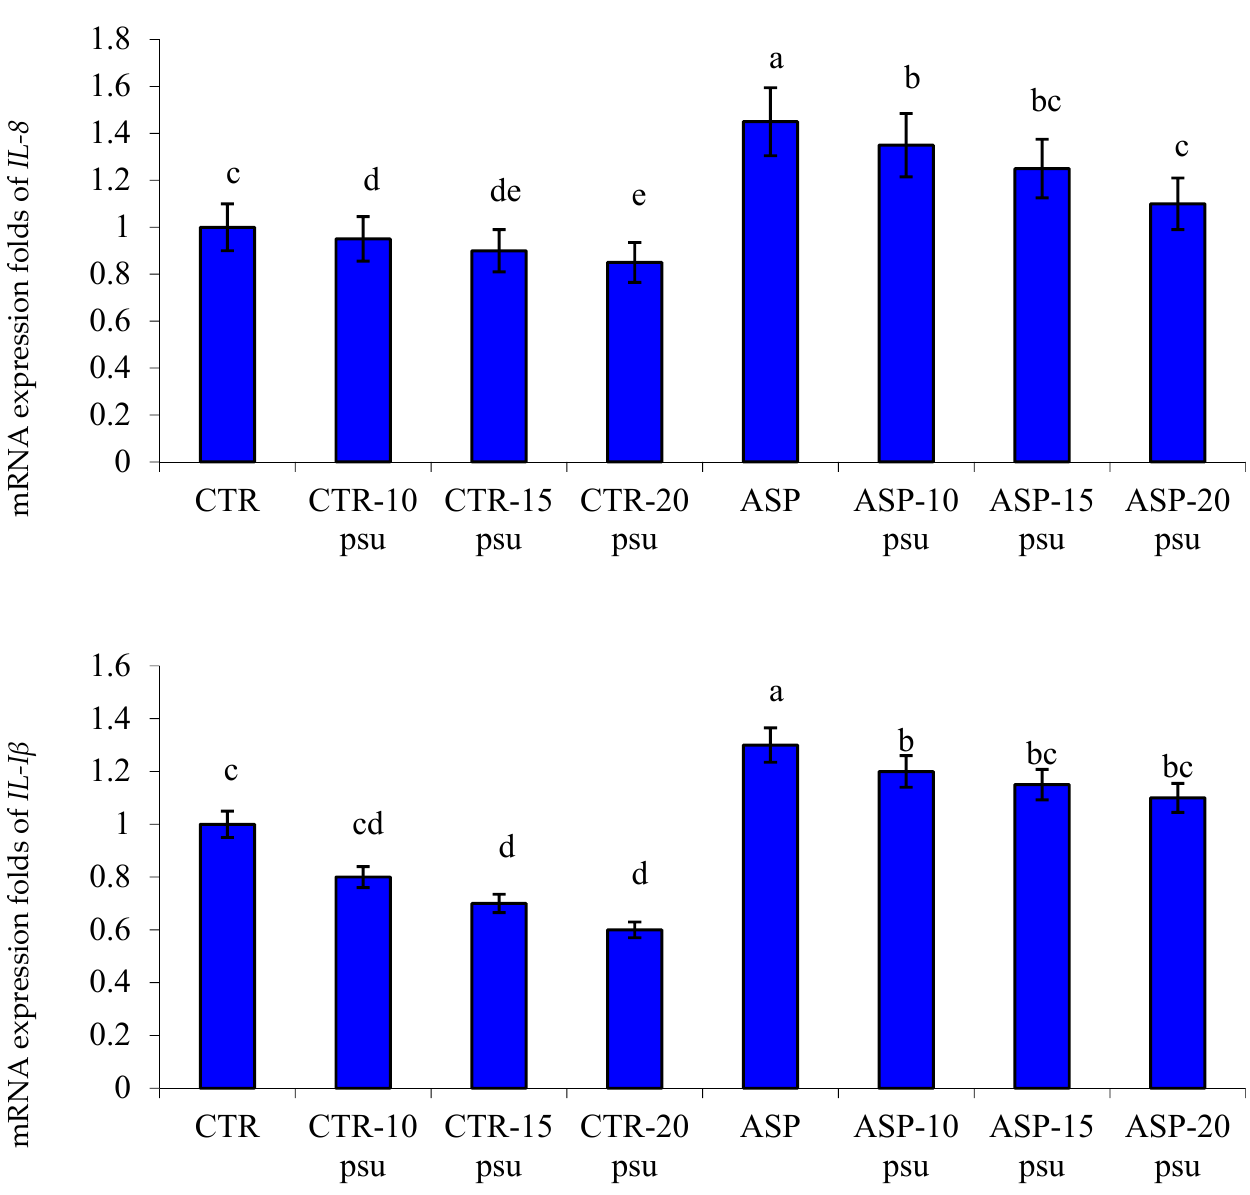
Figure 3. Changes in the mRNA expression folds of hepatic IL-8 and IL-1 β genes in Nile tilapia fed a basal diet (CTR) in comparison to those fed on diets supplemented with Aspergillus oryzae (ASP) for 12 weeks and then exposed to different salinity levels for 15 days (10, 15, and 20 psu). Bars of each variable assigned by different letters are statistically significant. p values of Two-way ANOVA (ASP = 0.022, salinity = 0.034, and ASP × salinity interaction = ˂ 0.001).